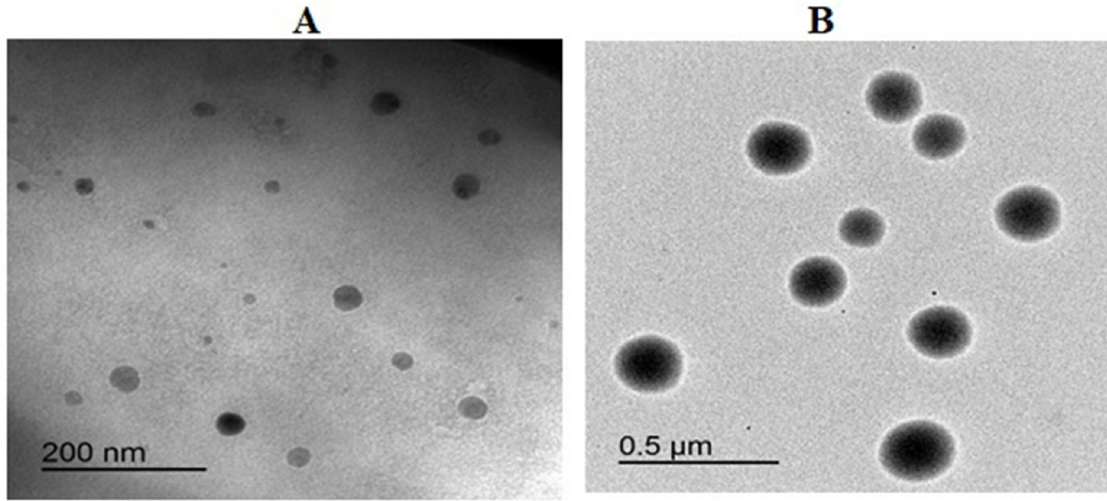
Fig 2. TEM images of RLX-TPGS-transferosomes (A) and RLX-TPGS-transferosomes-TAT